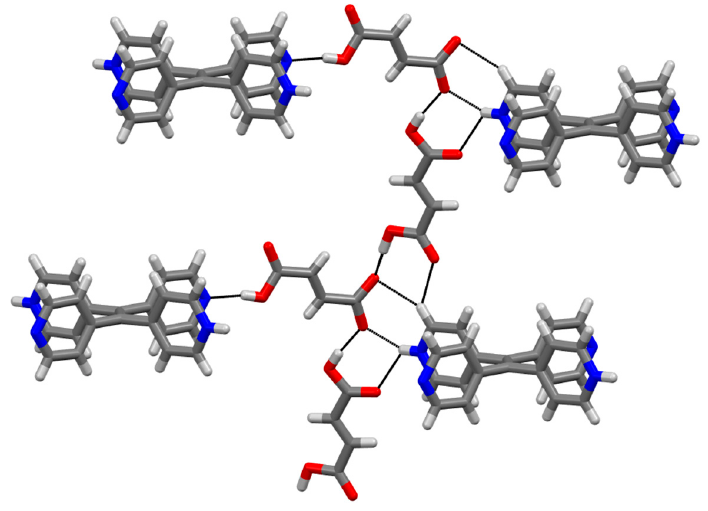
Figure 8. 2D chains of 7 fumarate assemblies are connected in the third dimension by hydrogen bonding to neutral fumaric acid components.